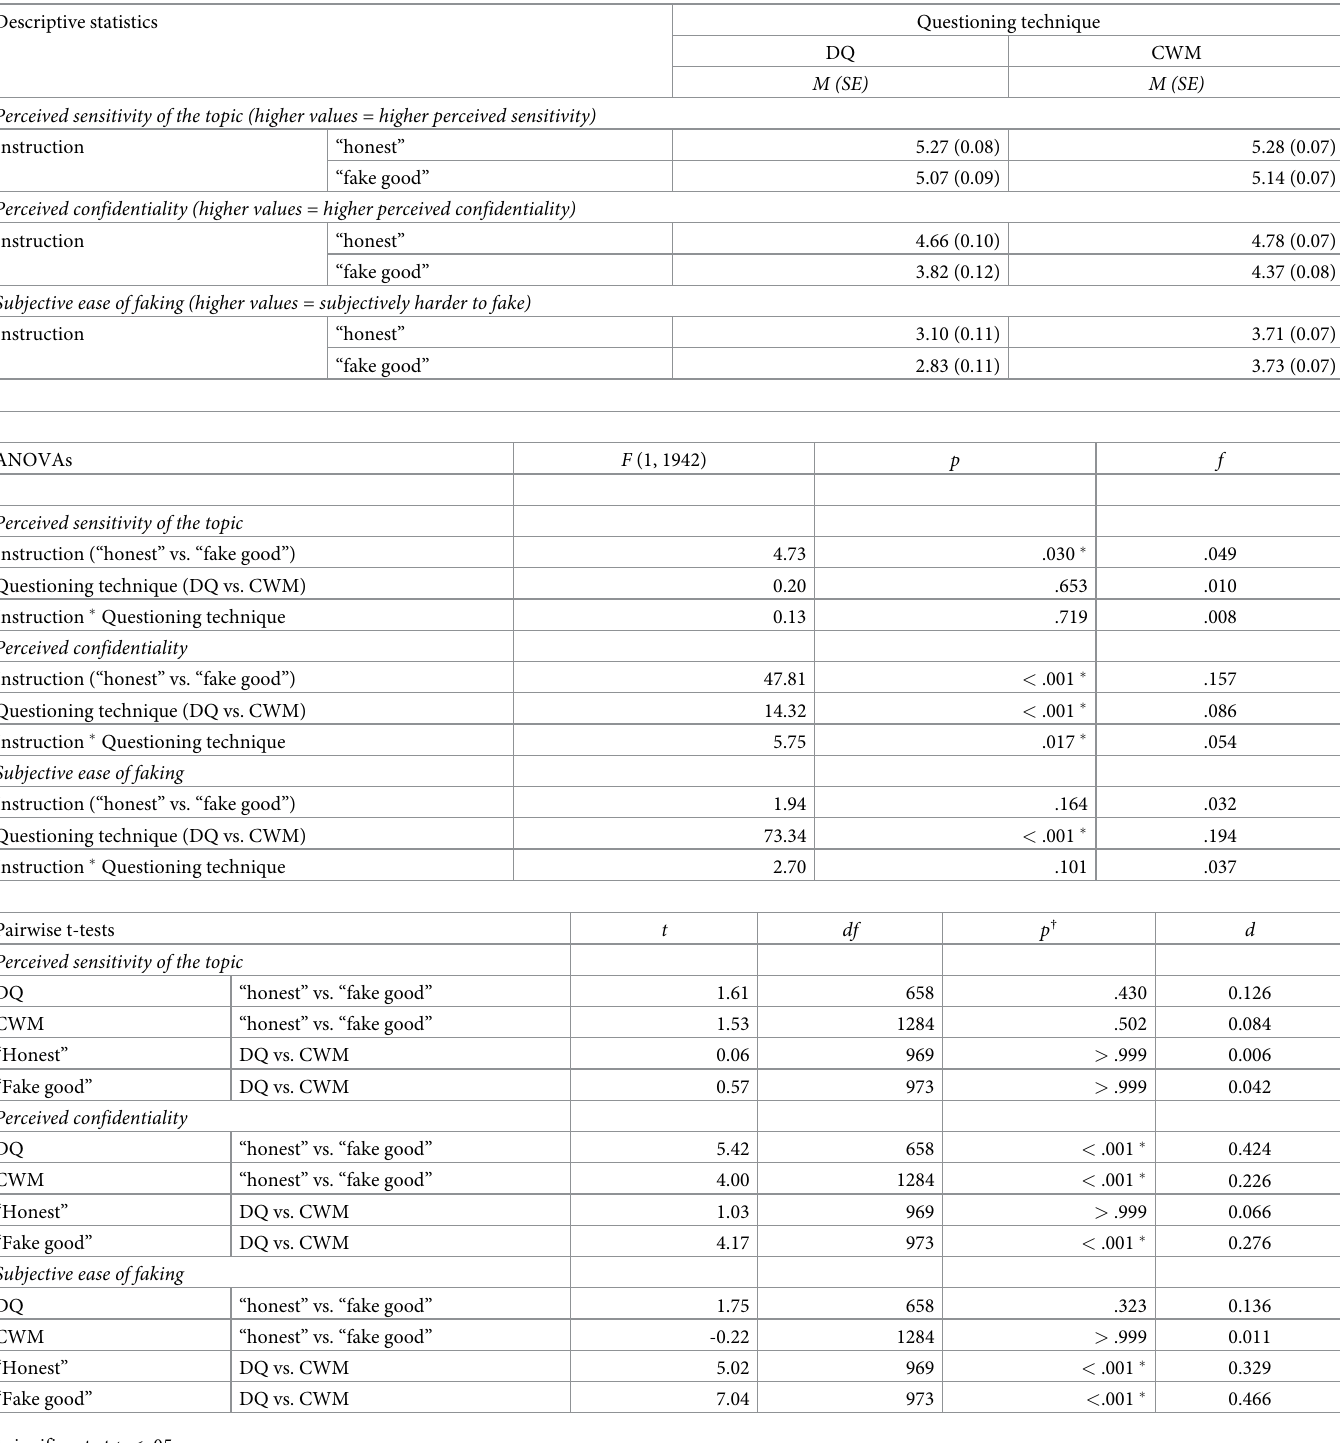
Table 3. Descriptive statistics, ANOVA results, and pairwise t-test results for perceived sensitivity, perceived confidentiality, and subjective ease of faking. Descriptive